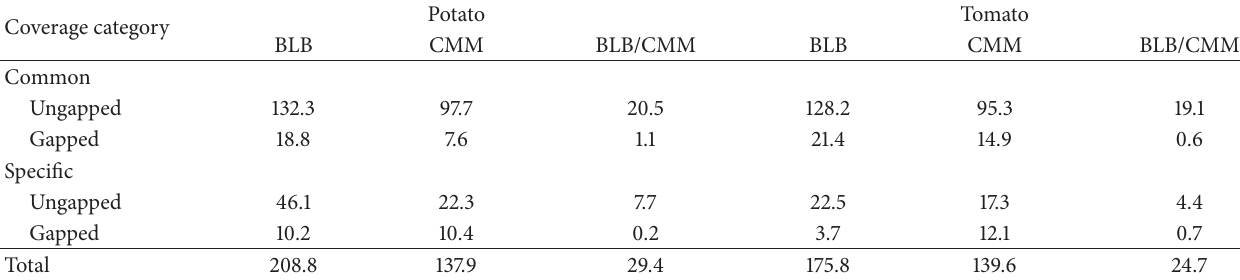
Table 2: Number of nucleotides (in Kbp units) covered by DArT alignments. For details on coverage categories, see Section 2. Coverage category Common